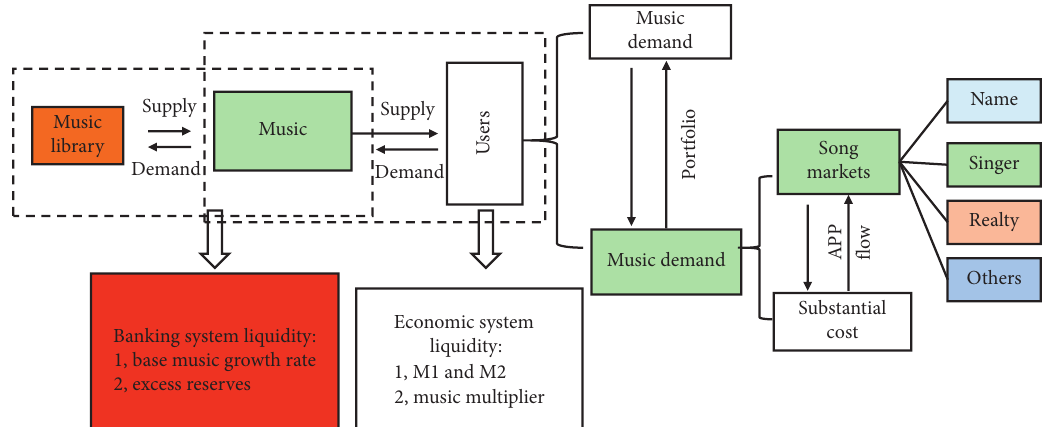
Figure 3: Music information display.